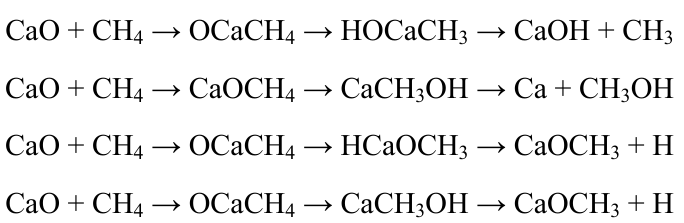
Figure 3. Relationship of NO formation and reburning gas content: ( a ) Homogeneous N decomposition; ( b ) Heterogeneous N (N O = 2000 ppm, N 2